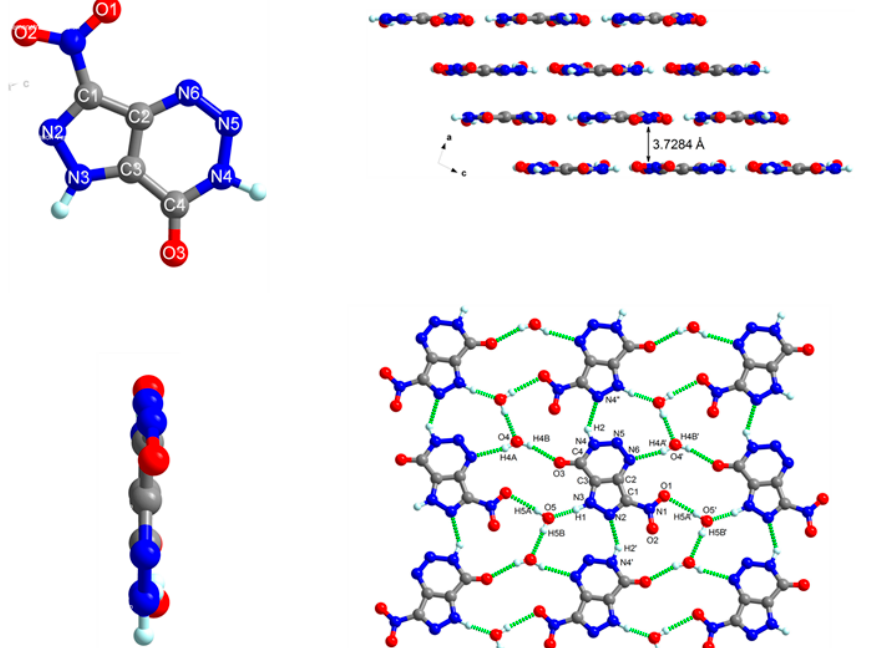
Figure 3. Molecular structure of NPTO · 2H 2 O and its crystal packing.